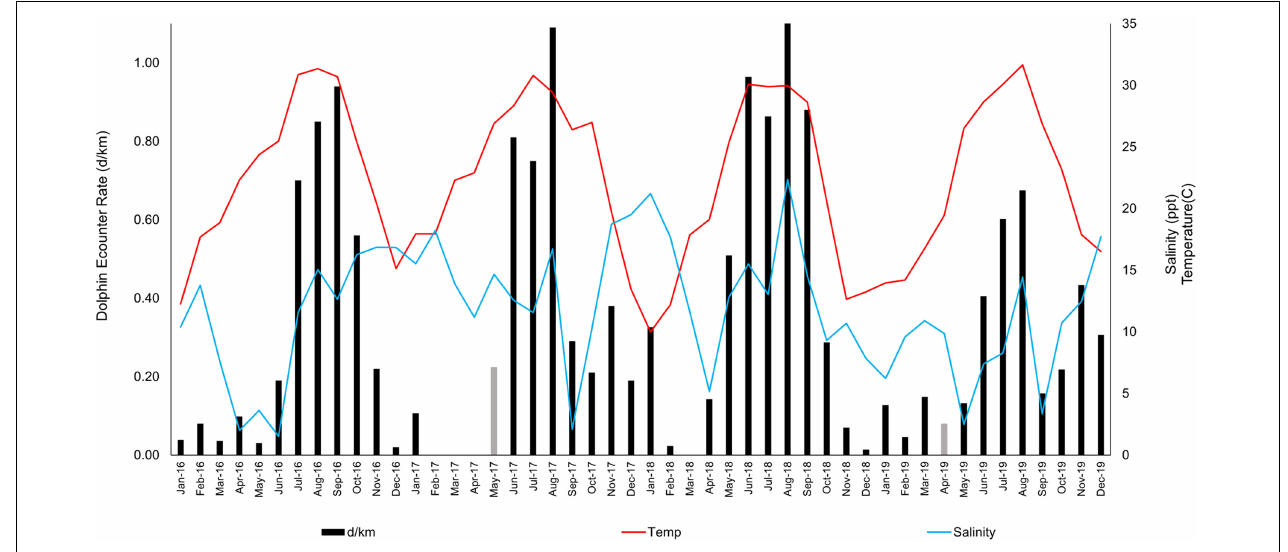
FIGURE 2 | Encounter rates of bottlenose dolphins ( Tursiops truncatus ) (dolphins/km) in upper Galveston Bay, Texas from January 2016 to December 2019. The monthly average mid-column water temperature ( ◦ C) and salinity (ppt) recorded at environmental profile stations is displayed. Due to inclement weather, effort in May 2017 and April 2019 was insufficient to cover the study area. Encounter rates displayed in gray correspond to the overall monthly averages for May and April. Values reported for June to December 2016 and June to December 2017 were previously published in Fazioli and Mintzer